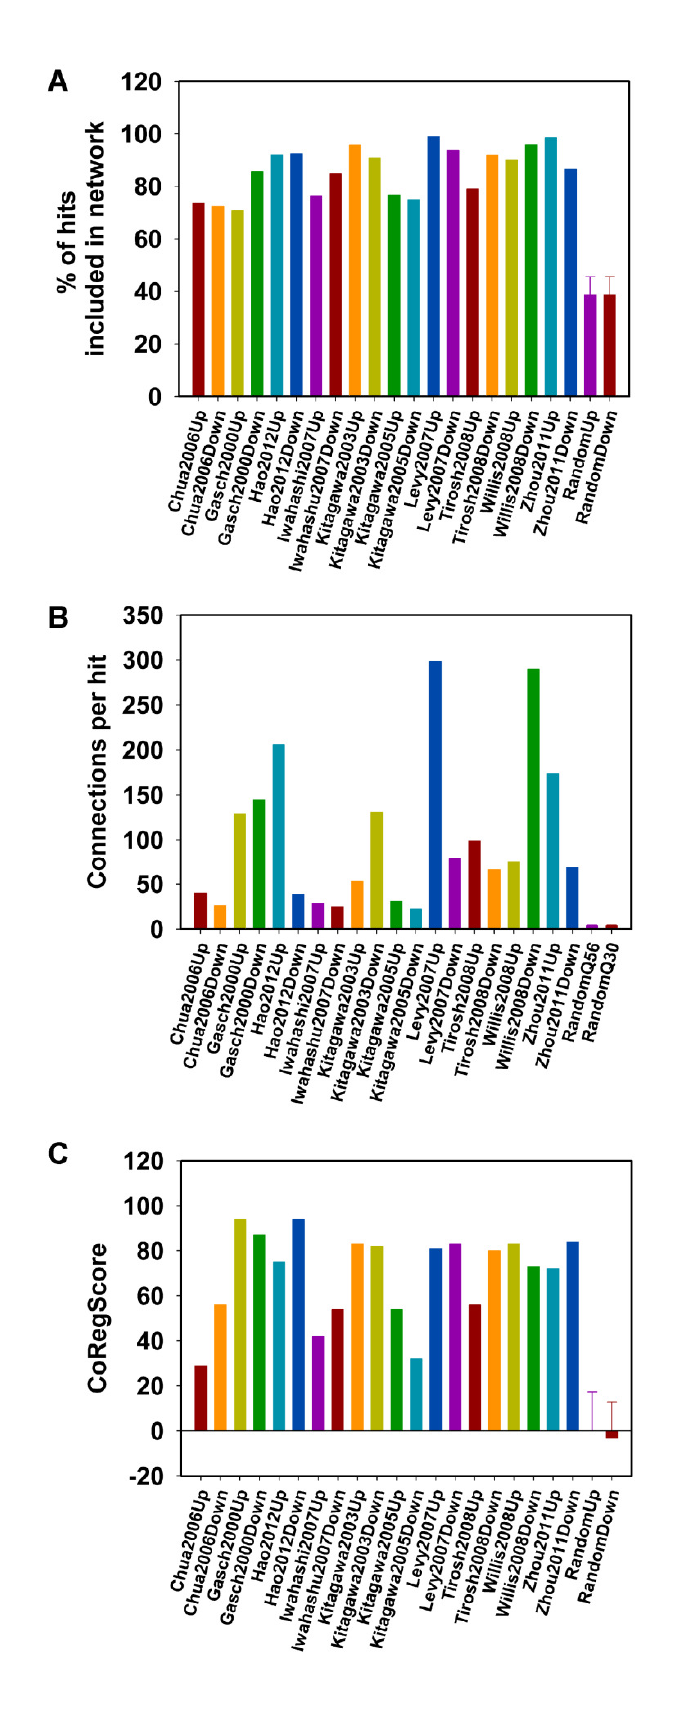
FIGURE 5: Evaluation of parameters for different exper- imental setups. Different microarray experiments were used to test the general applicability of the clustering approach, the connectivity parameters and the CoReg- Score. (A) Depicted here is the percentage of hits in- cluded within the network upon analysis of the top100 connected by 20 co-regulators obtained from SPELL. (B) The average number of connections per hit is shown under the same conditions. (C) The CoRegScore is calcu- lated for each data set after addition of up to 50 con- nectors and compared to the values for random data sets derived